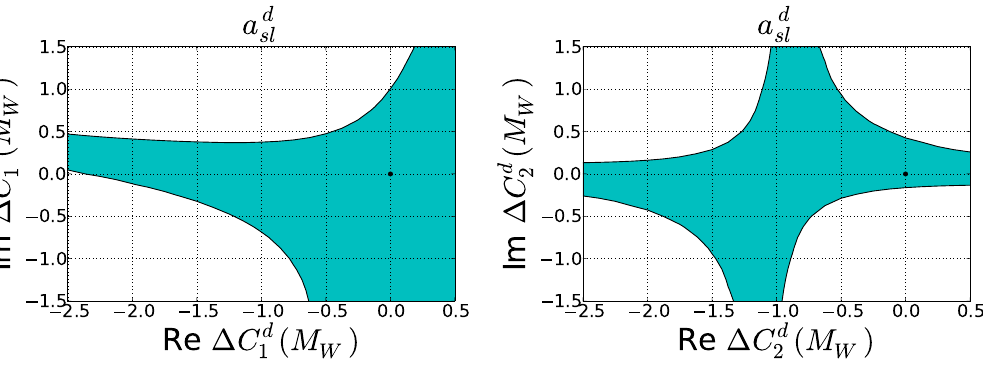
Figure 17 . Potential regions for the NP contributions in (cid:1) C d semileptonic asymmetry a d at 90% C.L. . The black point corresponds to the SM value. For the pur- sl poses of illustration we have made the universality assumptions: (cid:1) C d;uu